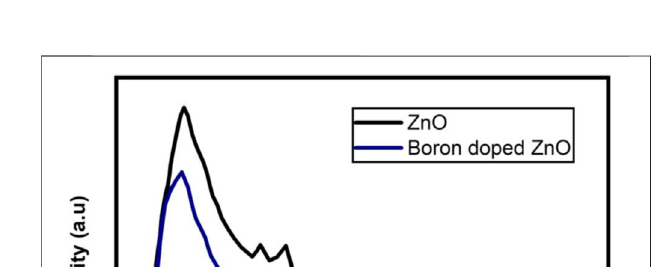
FIGURE 3 | EDX spectrum of pure ZnO and B-doped ZnO-NSs.